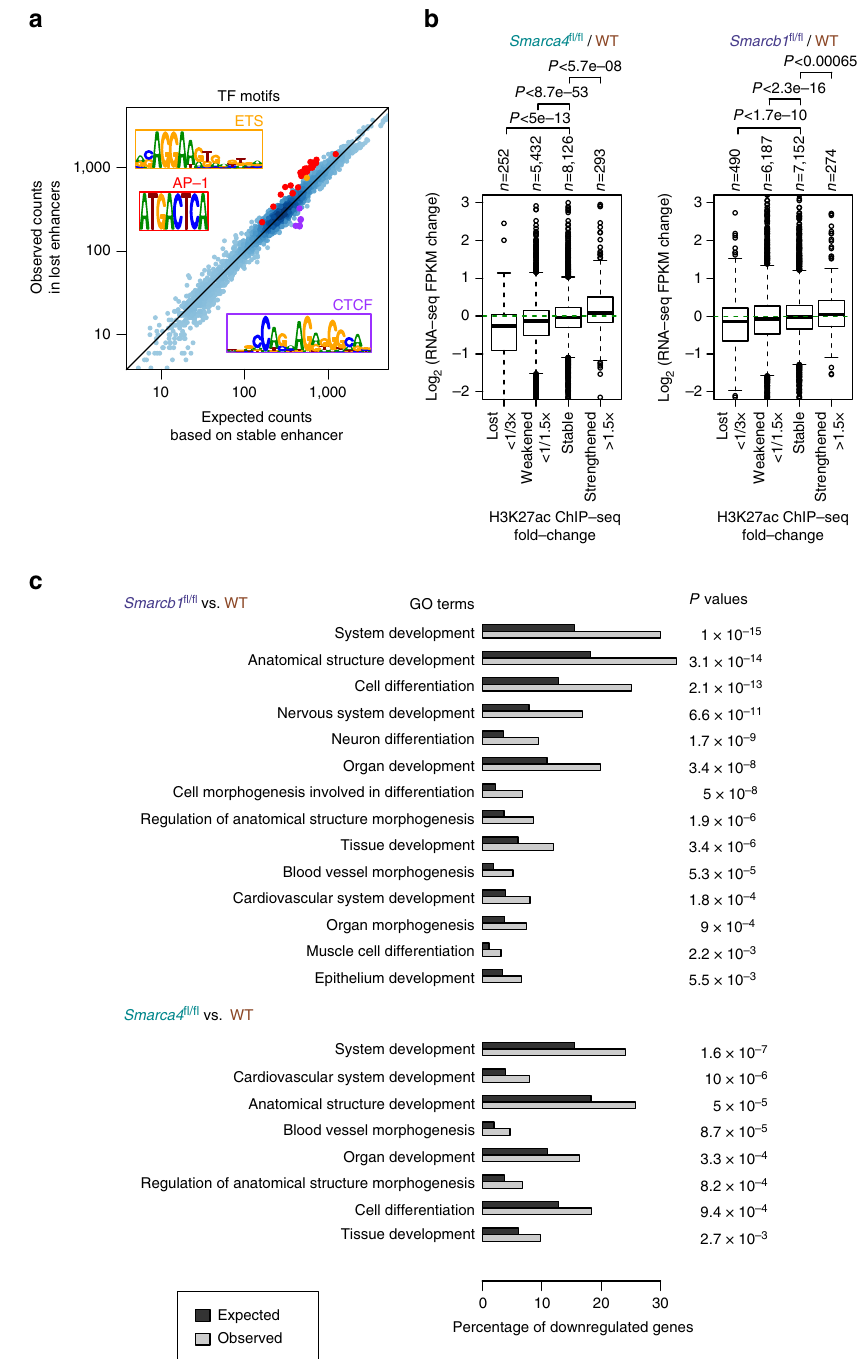
Figure 4 | SWI/SNF subunit deletion results in downregulation of specific developmental targets. ( a ). Number of TF motif matches within lost enhancers relative to an expectation based on numbers in stable enhancers. The strongest enrichment/depletion is seen for motifs similar to AP-1, ETS and CTCF motifs, which are highlighted. ( b ). Correlation of nearby gene expression (5–100kb) changes with H3K27ac signal changes at enhancers upon Smarcb1 or Smarca4 deletion. The boxes indicate first, second, and third quartiles, and whiskers show 1.5 (cid:2) interquartile range below and above the first and third quartile, respectively. Two sided t -test P values are shown. ( c ) Selected GO terms enriched in downregulated genes. Hypergeometric test P values are shown after Benjamini–Hochberg correction for multiple-hypothesis